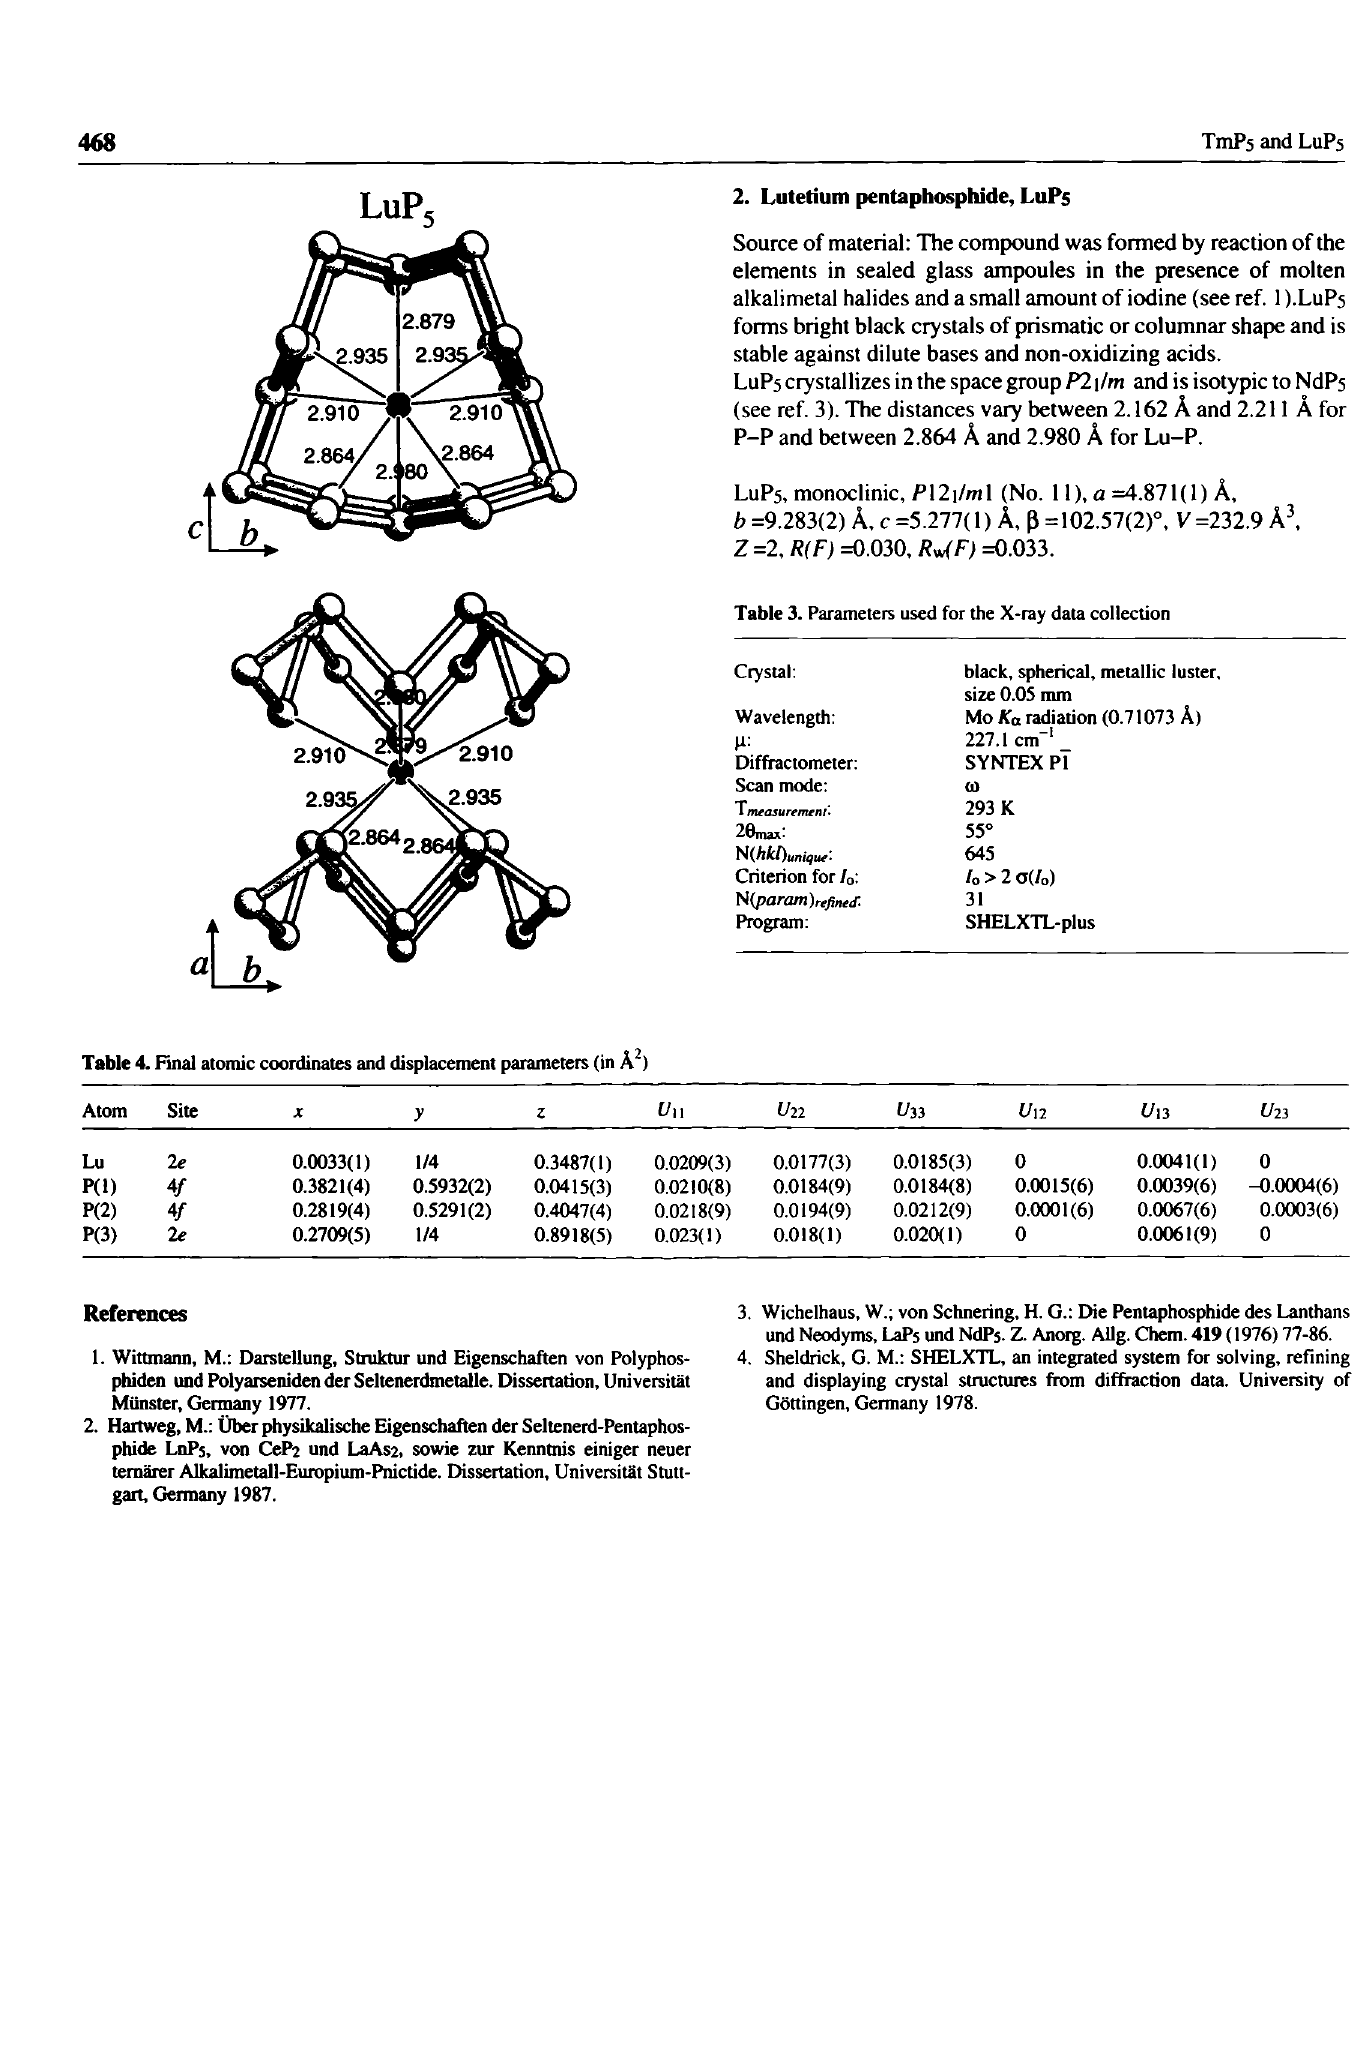
Table 3. Parameters used for the X-ray data collection Crystal: